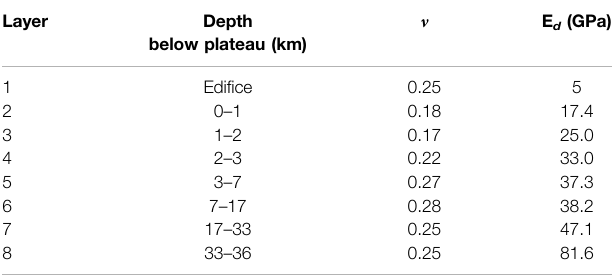
TABLE 3 | Mechanical properties assigned to each subdomain in the model. The plateau surrounding Hasan Da ğ is set to z (cid:1) 0 m in the model, thus the edi fi ce extends to a height of z (cid:1) 2532 m. See Eq. 8 and Supplementary Table S1 for further information on the derivation of the